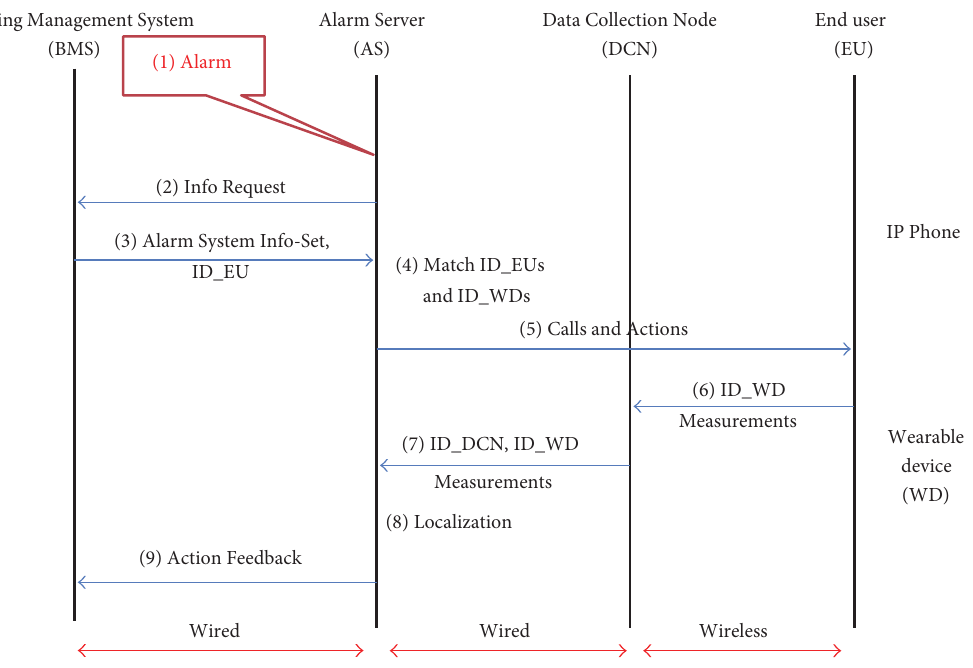
Figure 2: Content of the controlled setup.